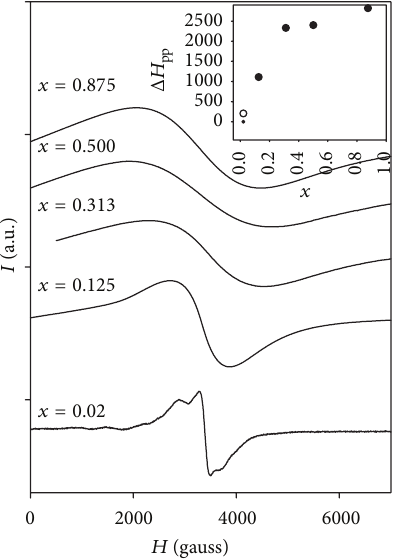
Figure 1: ESR spectra at room 𝑇 . The peak-to-peak linewidth ) values for the same samples are reported in the inset (black ( Δ𝐻 pp circles). The white circle refers to Δ𝐻 ≈ 2 for the 𝑥 = 0.02 𝑔 eff